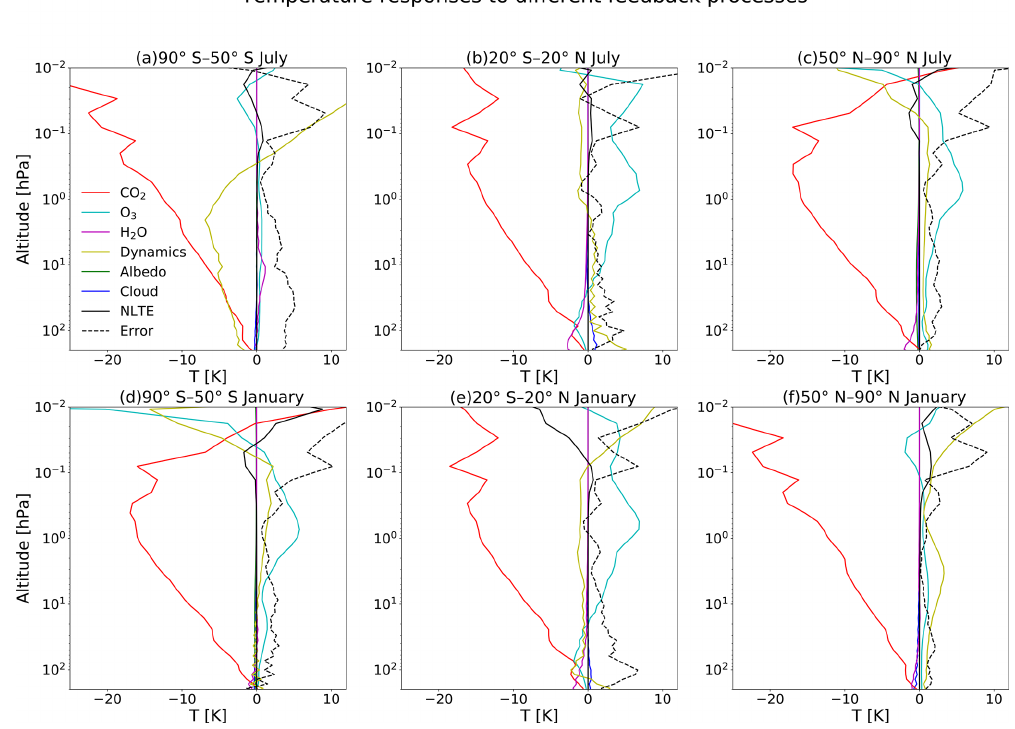
Figure 12. Vertical profiles of the temperature responses to the changes in CO 2 , and various feedback processes in July (a, b, c) and January (d, e, f) due to double CO 2 and changed SSTs in the atmosphere between 200 and 0.01hPa for regions from 50 ◦ N and S, both poleward and in the tropics (20 ◦ S–20 ◦ N), as calculated by CFRAM.